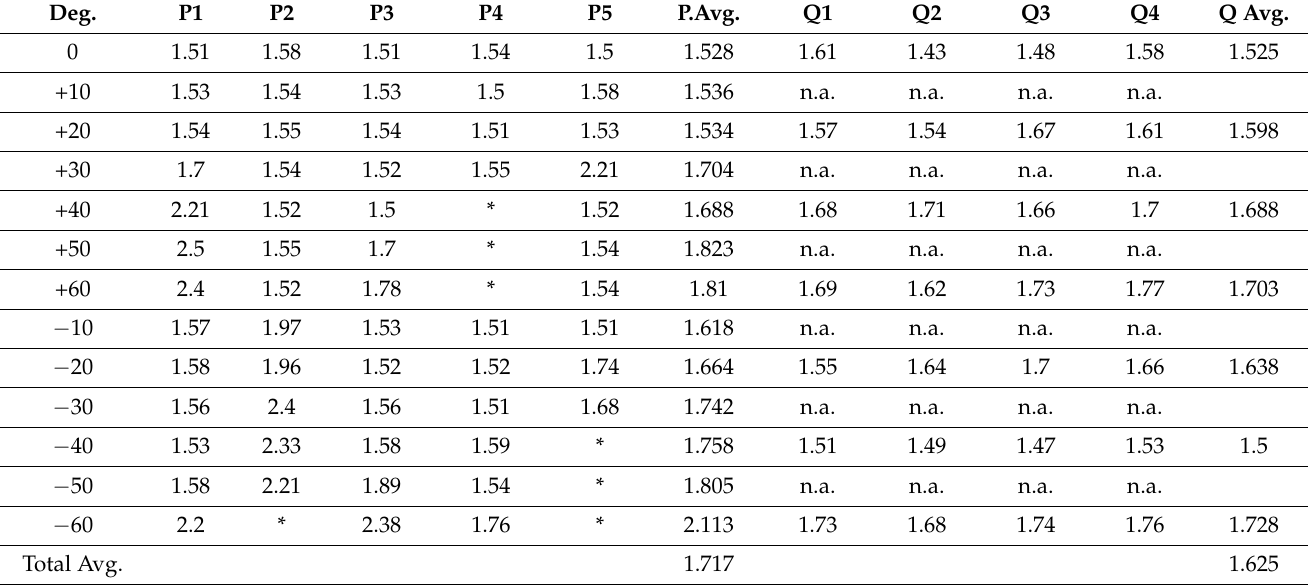
Table 2. Deviations of the projections of markers from physical markers on head phantoms in